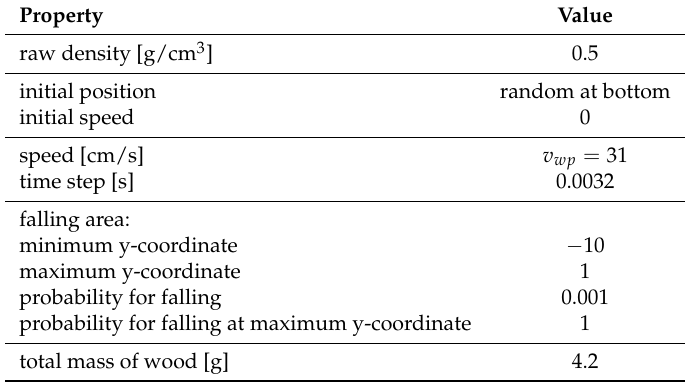
Table 1. Properties of wood particles for all scenarios.